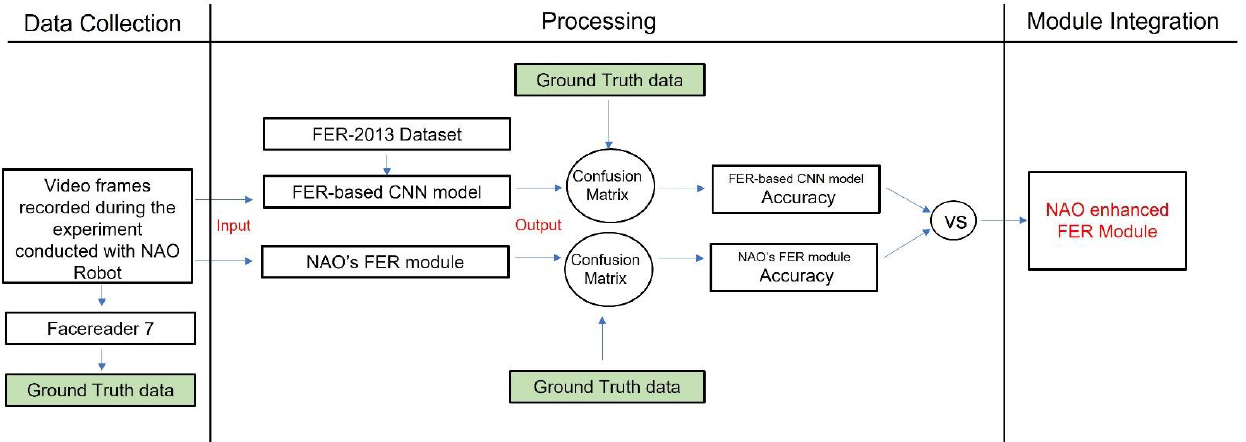
Figure 1. The overall paper processing workflow.